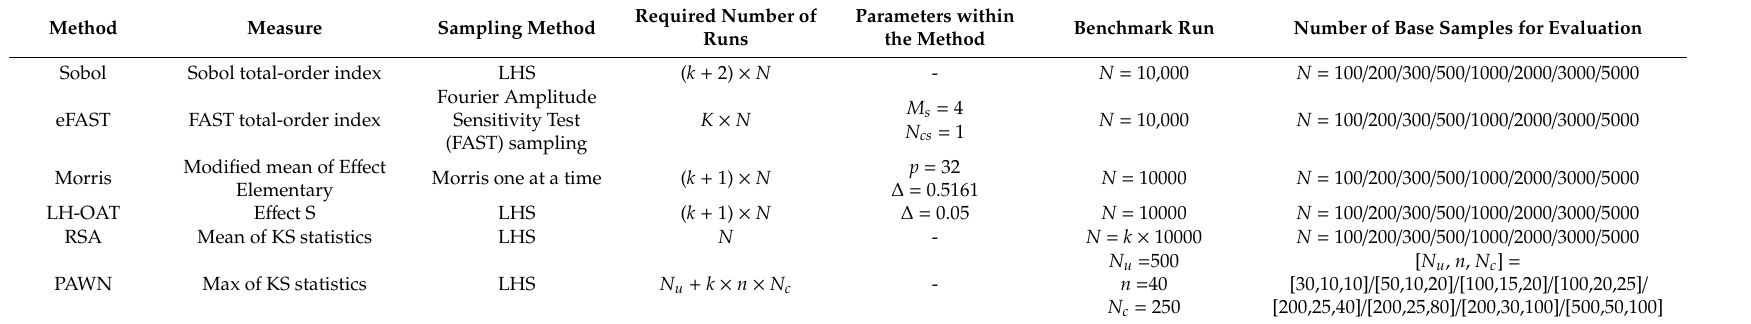
Table 4. Experimental set-up for evaluation of Sensitivity Analysis (SA)